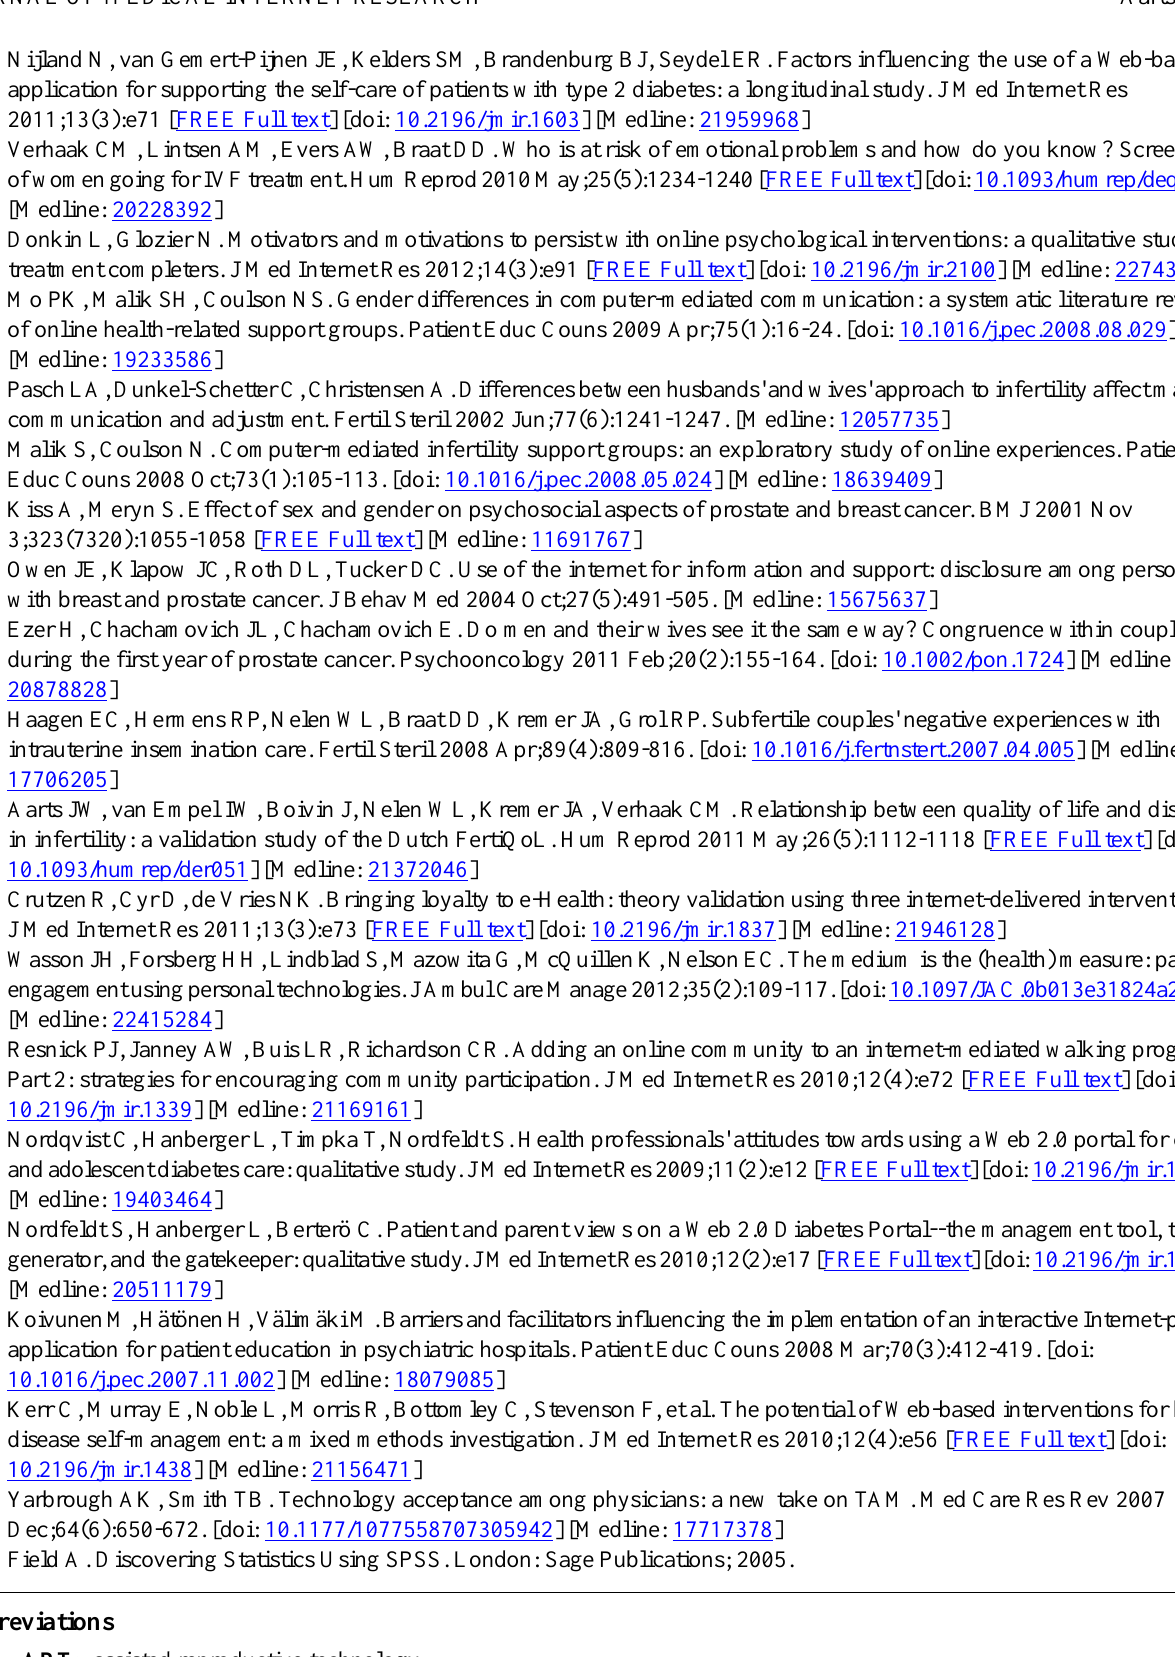
Abbreviations ART: assisted reproductive technology ICSI: intracytoplasmatic sperm injection IUI: intrauterine insemination IVF: in vitro fertilization OI: ovulation induction